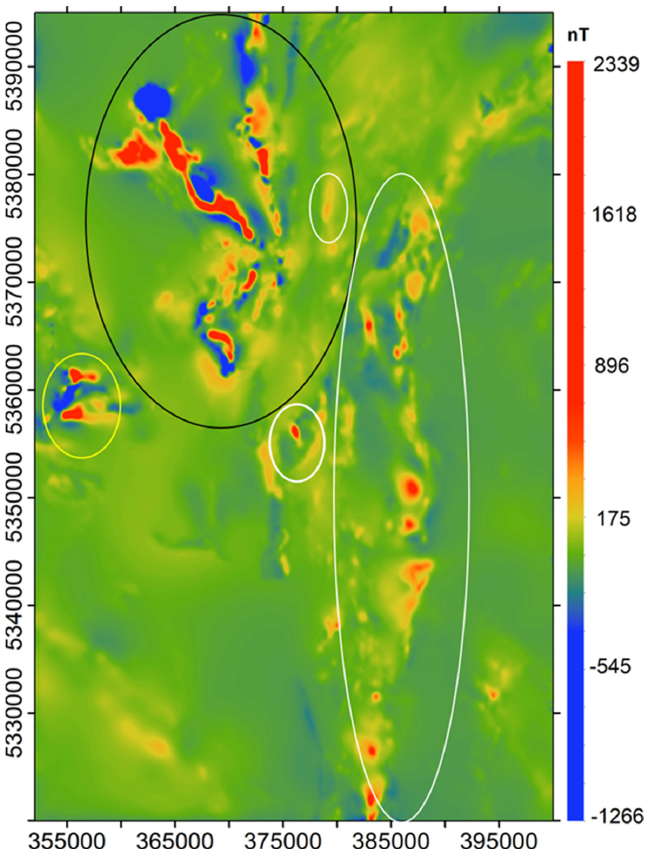
Figure 12. The TMI residual misfit of the Rosebery–Lyell reference model after homogeneous inversion (rms misfit 143.65 nT). Black and yellow ellipses represent broad-scale features associated with ultramafic complexes suggesting substantial compositional variation or inadequate model geometry. White ellipses highlight finer-scale features in the magnetic residual misfit and are more confidently ascribed to volumes that are magnetically anomalous in a geological as well as geophysical sense, such as the magnetite alteration system at Red Hills (central white